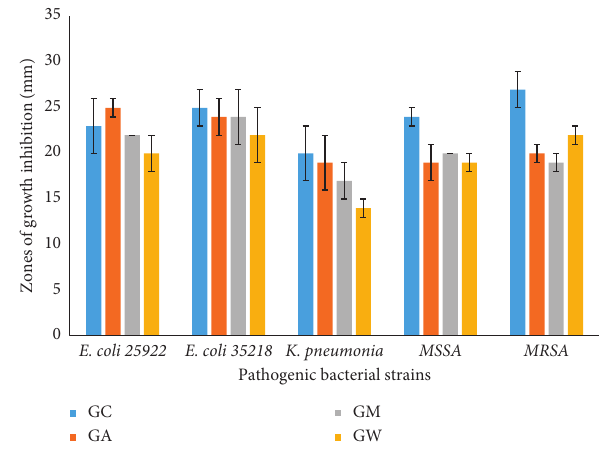
Figure 7: Antibacterial activity of P. grandiflora tuber extract conjugated with chemically synthesized gold nanoparticles against selected pathogenic bacteria. GC: chemically synthesized gold nanoparticles, GA: gold nanoparticles and acetone extract, GM: old nanoparticles and methanol extract, and GW: gold nanoparticles and water